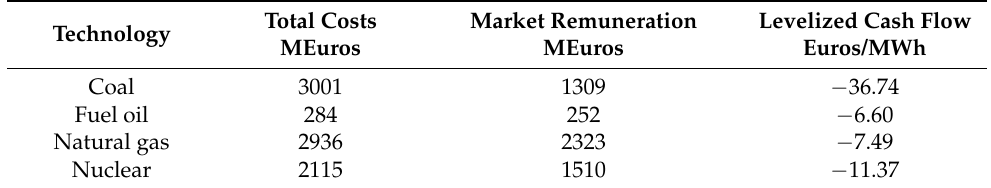
Table 4. Annual total costs, market remuneration and levelized loss of thermal technologies in